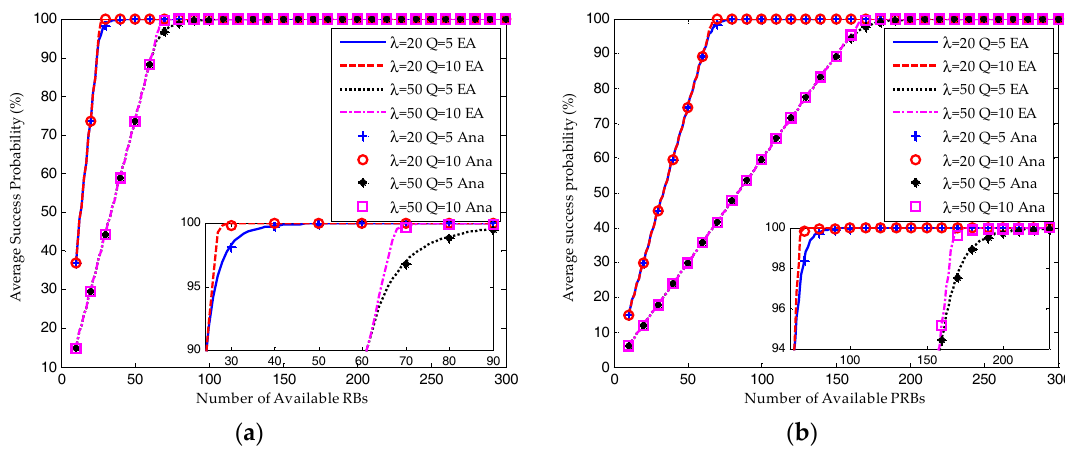
Figure 7. Comparison of average success probability between equilibrium analysis and iterative analytical results (W BO = 0): ( a ) S-ALOHA protocol; ( b ) TDMA protocol.